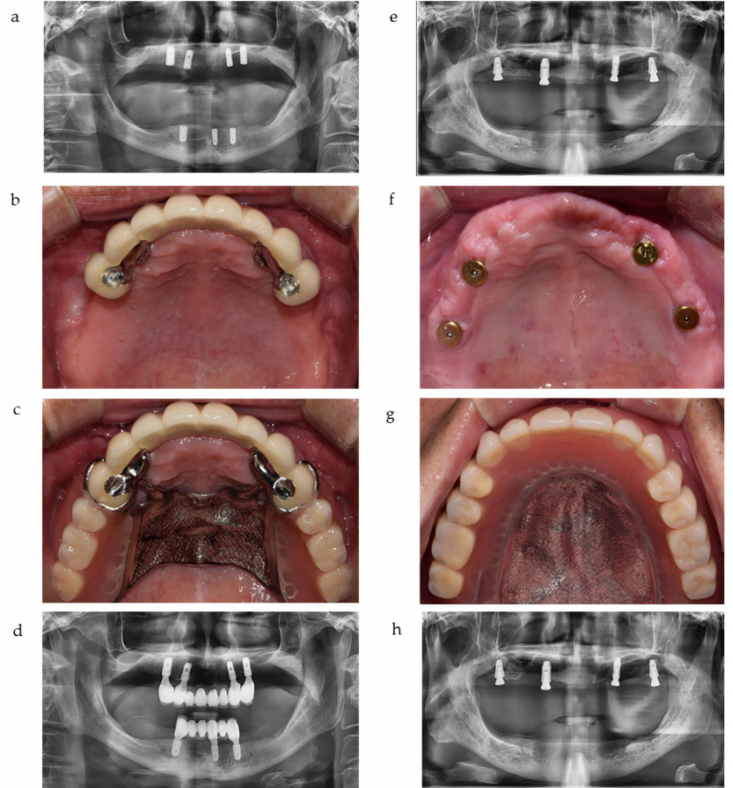
Figure 1. Representative cases of implant-crown-retained removable partial dentures (IC-RPD) and implant overdentures (IOD) in this study. ( a ) Implants were placed in anterior positions due to anatomical limitations. ( b ) Intraoral view of IC-RPD case. ( c ) Delivery of IC-RPD. ( d ) Panoramic radiograph of IC-RPD case. ( e ) Four implants were placed with lateral sinus floor elevation and bone augmentation. ( f ) Intraoral view of IOD case. ( g ) Delivery of IOD. ( h ) Panoramic radiograph of IOD